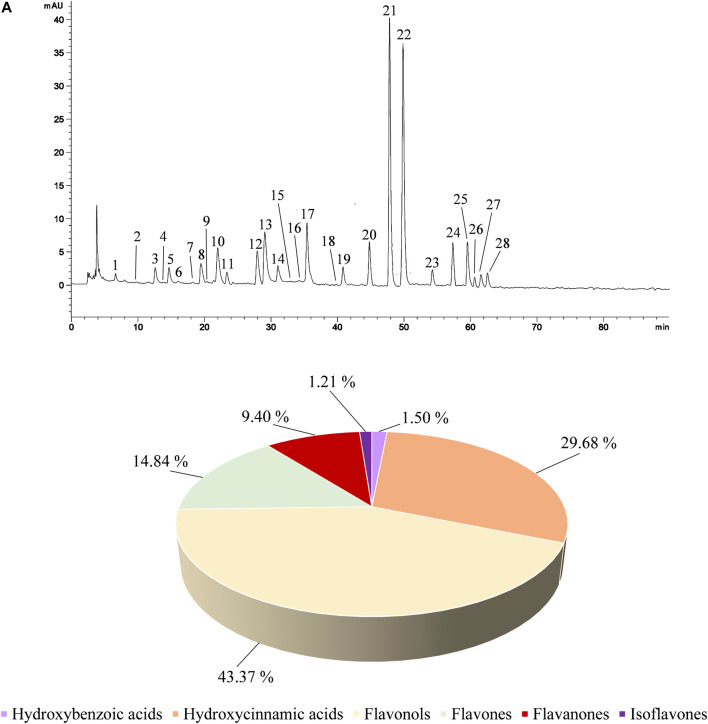
Representative LC-DAD chromatogram of CLJ acquired at 330 nm (A). Peak numbers refer to compounds listed in Table 1 according to their elution order. Panel B reports the composition of CLJ in terms of polyphenols classes expressed as mean area percentage with respect to all polyphenols identified.